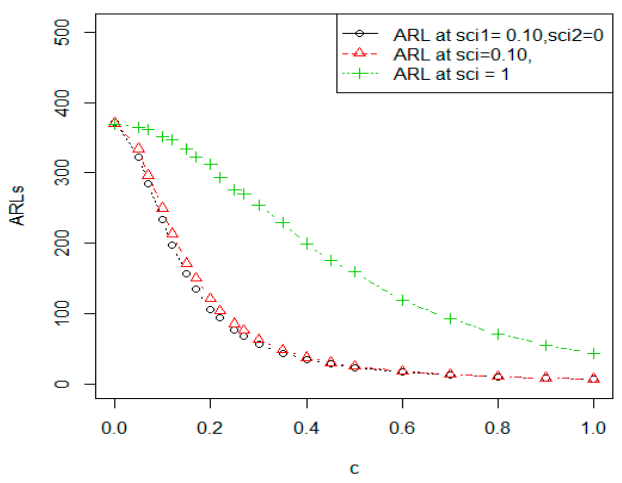
Figure 2. Graph of comparison of ARLs when r 0 = 370.